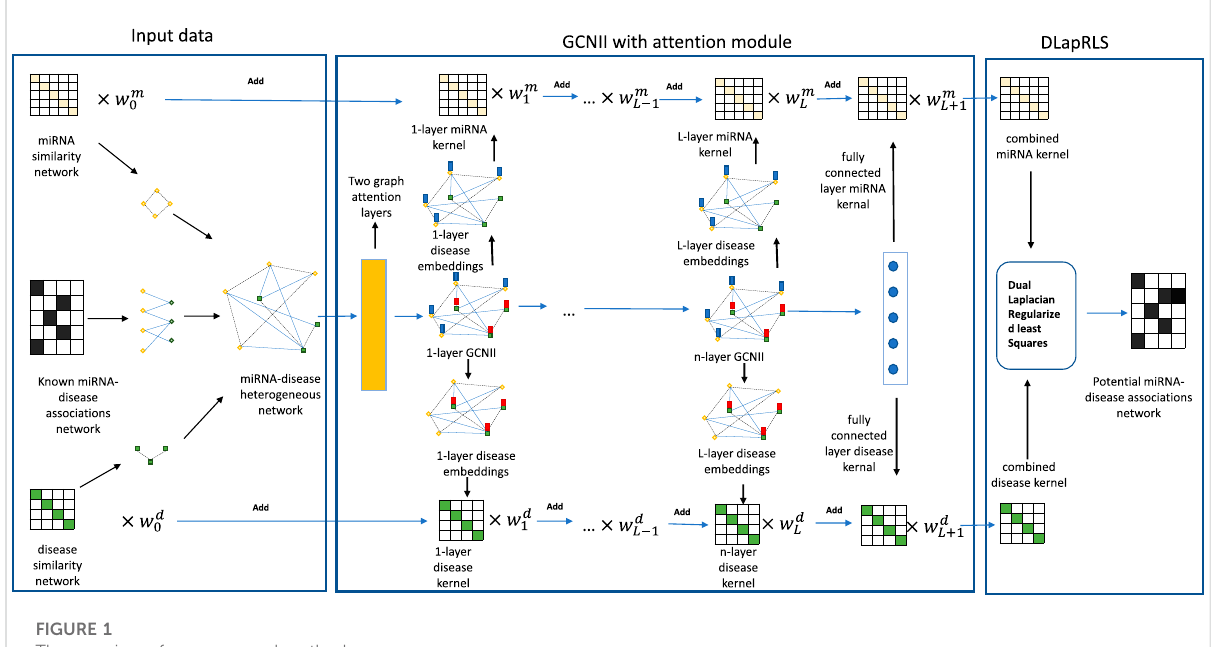
FIGURE 1 The overview of our proposed